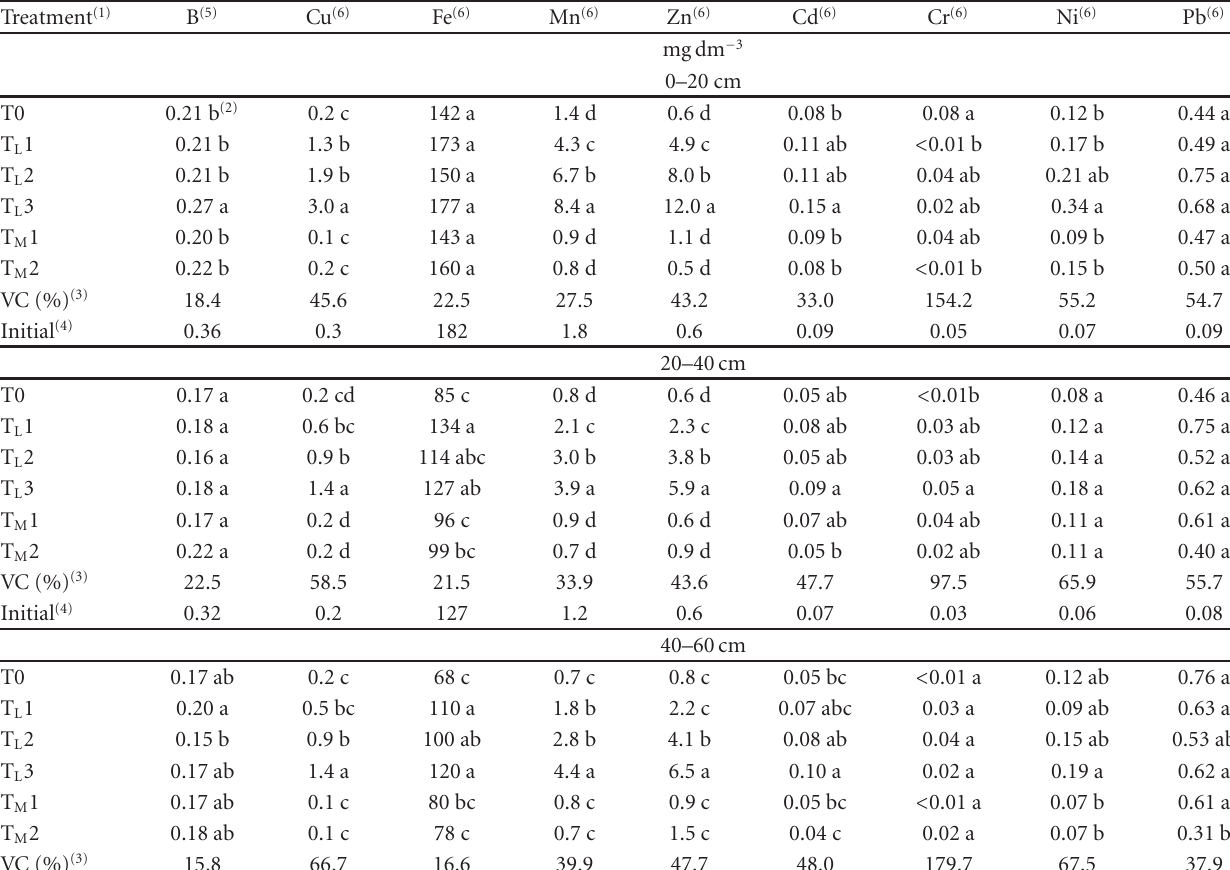
Table 4: Boron and DTPA-extractable metals from SS-treated soil after the first crop cycle at three sampling depths. Treatment